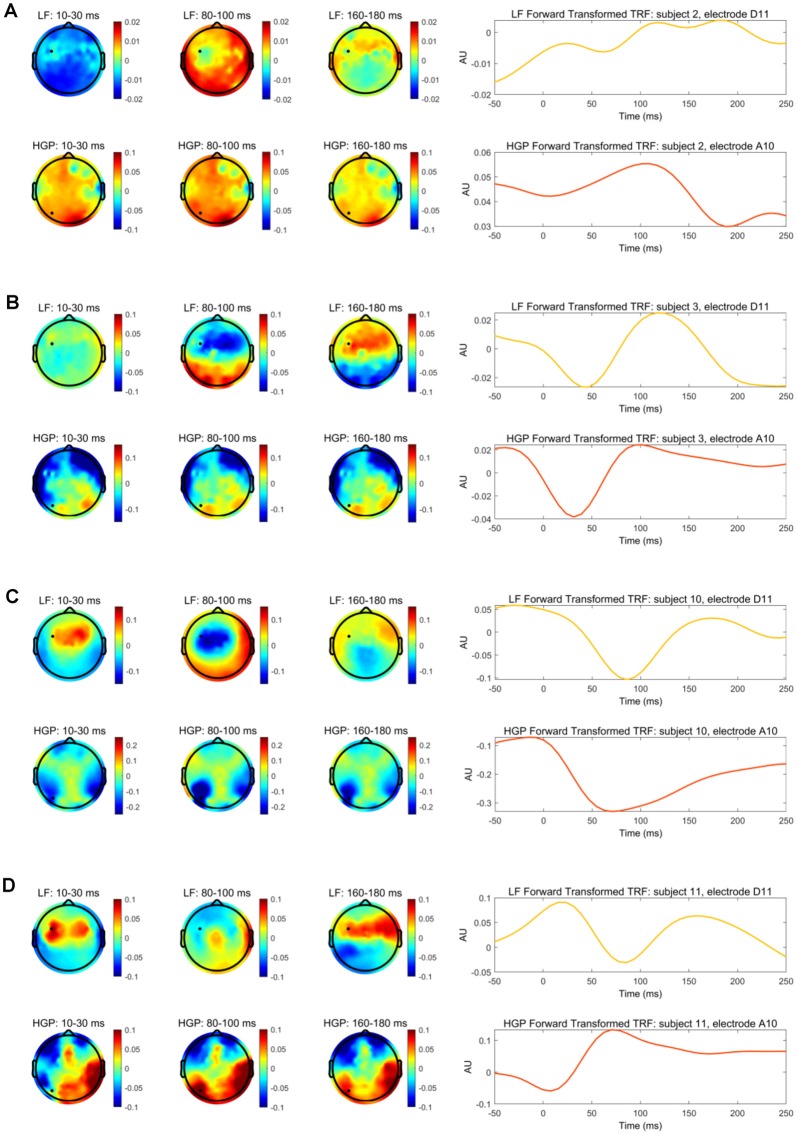
(A) The left panel depicts the transformed decoder weights at each electrode for subject 2. The top three topographies were calculated using LF EEG and the bottom three using HGP EEG. The black marker indicates the location for electrodes D11 and A10. The right panel shows subject 2’s temporal response function (TRF) calculated by transforming the decoder weights into the forward modeling domain. The LF TRF (yellow) is plotted for electrode D11 and the HGP TRF (red-orange) is plotted for electrode A10. (B–D) Same information as (A), but shown for subjects 3, 10, and 11, respectively.